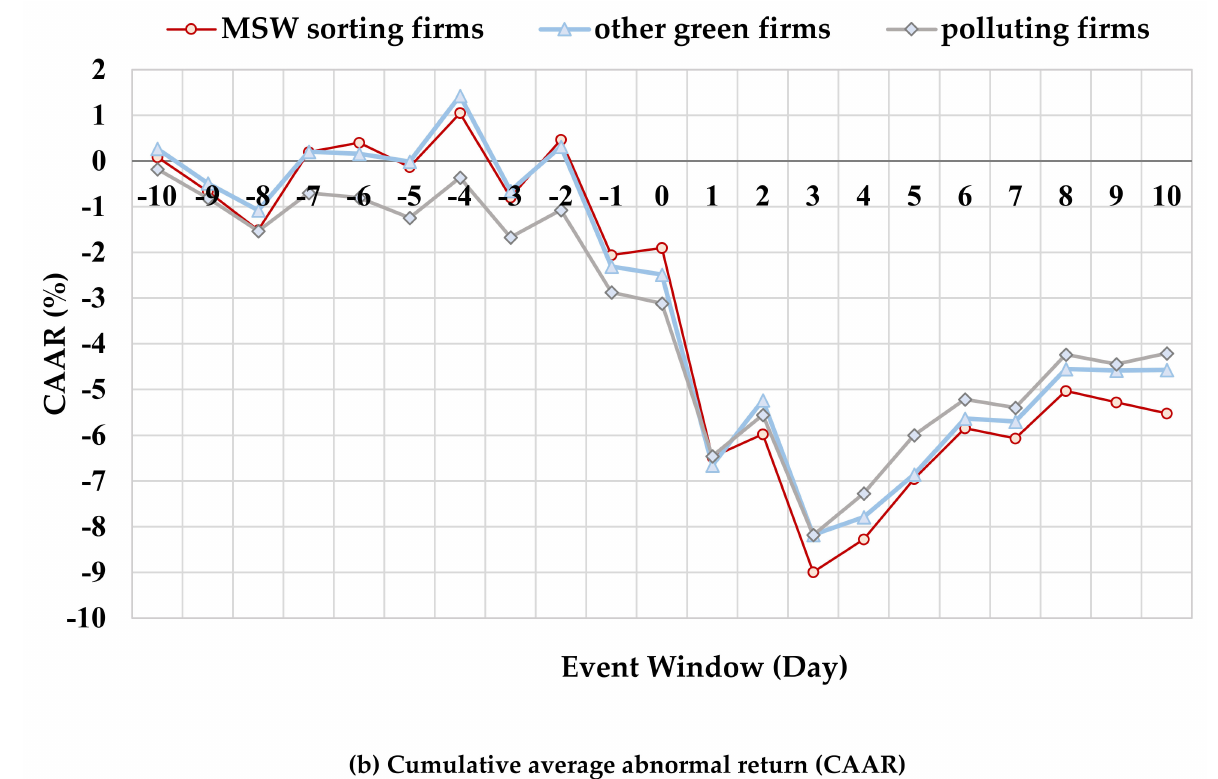
Figure 1. Trends of abnormal